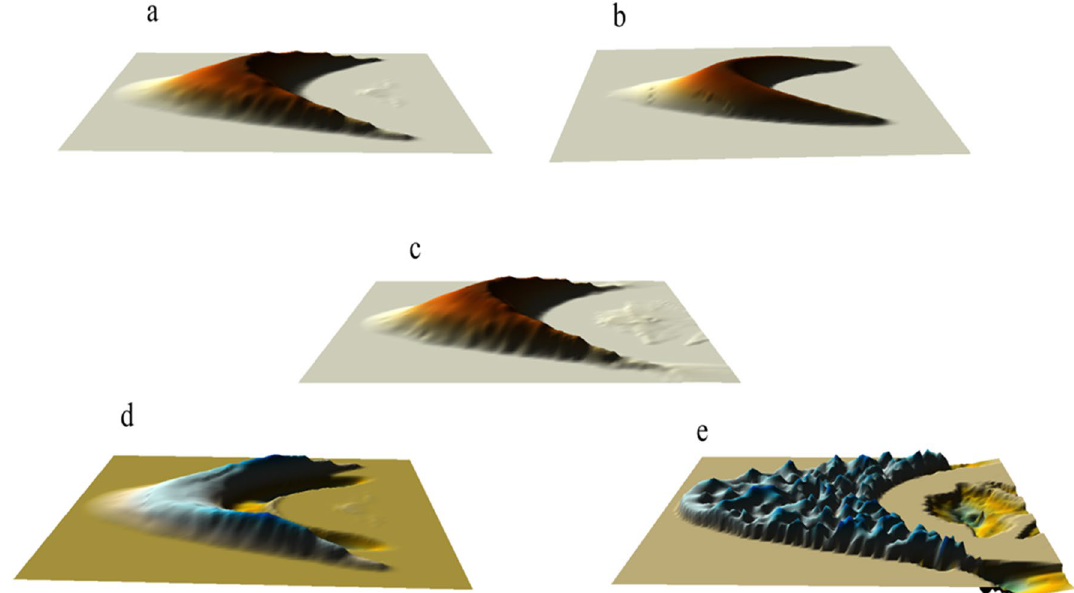
Figure 9. Simulation of the sand distribution on the leeward side in several cases. ( a ) At the wind velocity of 10 m s −1 ; ( b ) high Reynolds; ( c ) at the wind velocity of 12 m s −1 ; ( d ) difference between ( a ) and ( b ); ( e ) difference between ( a ) and ( c ). The map was plotted using Surfer 16 (https ://www.golde nsoft